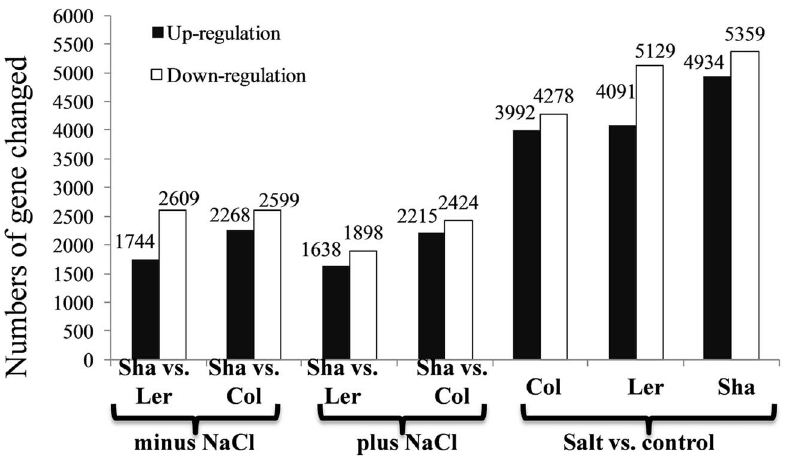
Figure 5. Numbers of overlapping transcripts changed between ecotypes and after salt treatment. Differentially expressed transcripts were those with P , 0.05 and fold change . 2. Genes commonly regulated between ecotypes or by salt treatment were highlighted in dotted rectangles and the detailed information of these genes was listed as in Table S1.